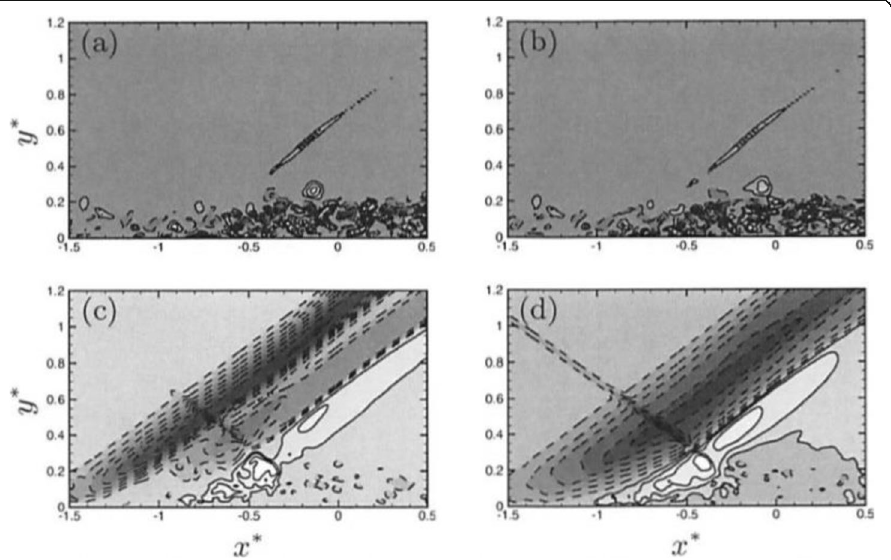
Fig. 2 Filtered pressure fluctuation fields. High-pass and high-frequency data (frames a - b ) and low-pass and low-frequency data (frames c - d ). Color scale from white (negative values) to black (positive values)